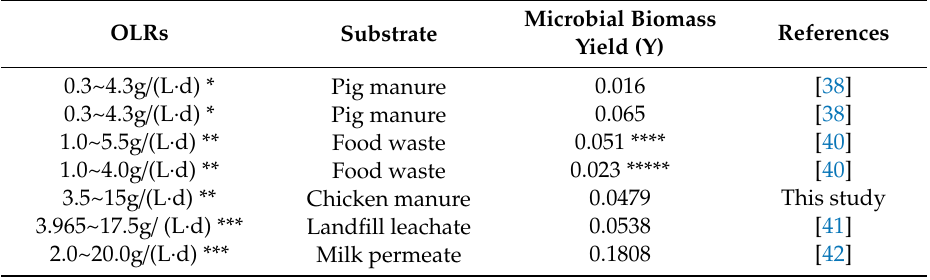
Table 3. Comparison of microbial biomass yield values in di ff erent OLRs for AD. OLRs Substrate